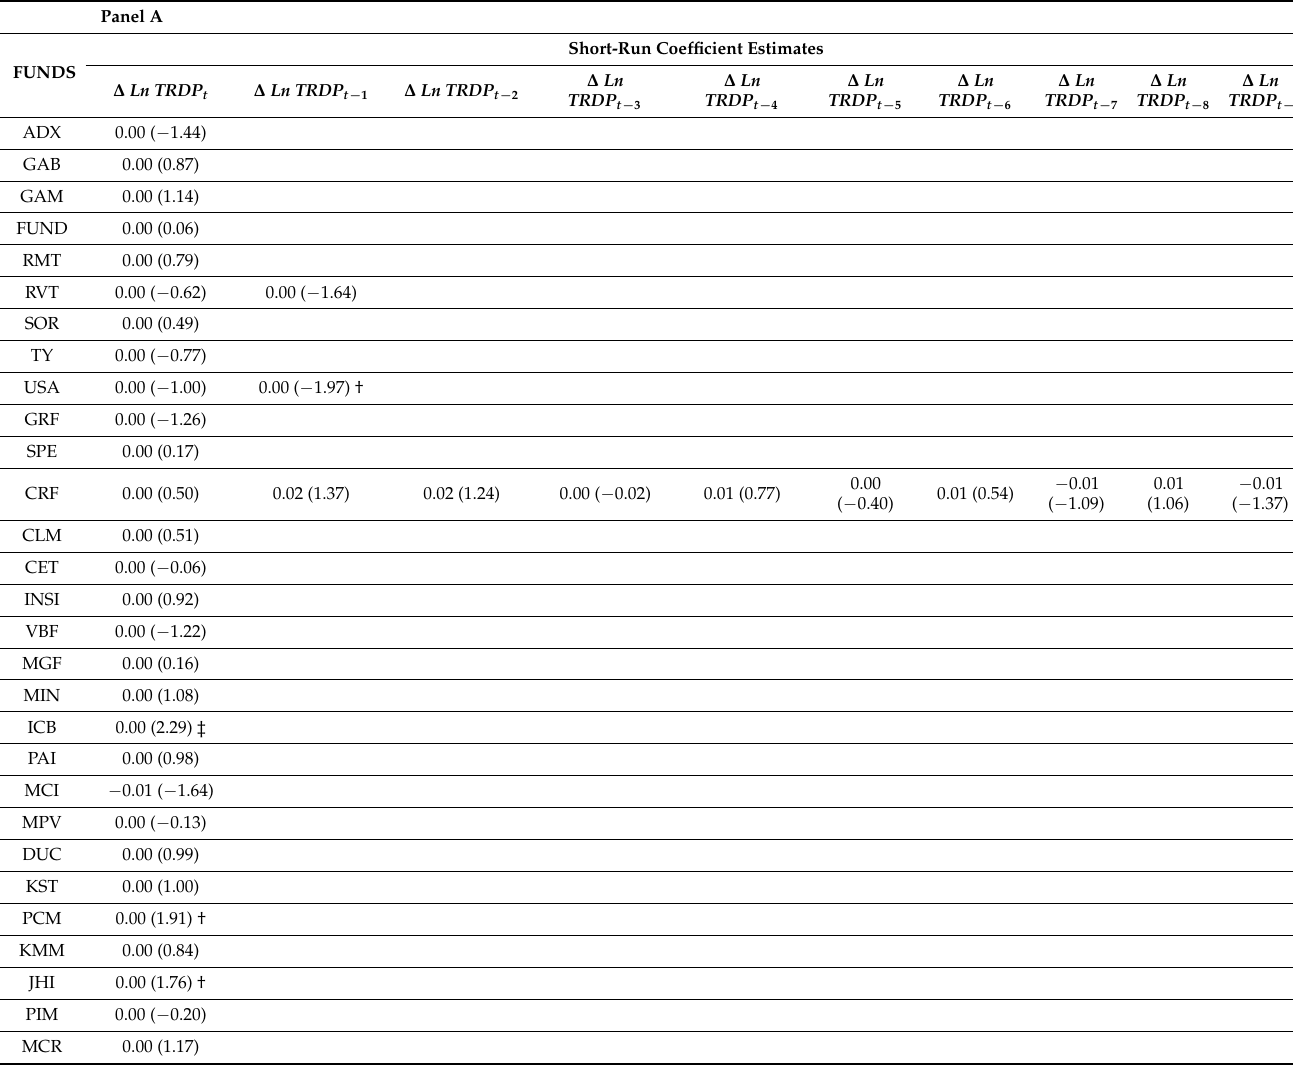
Table 11. Short-Run Coefficient Estimates—Linear ARDL—Model P = f (NAV,